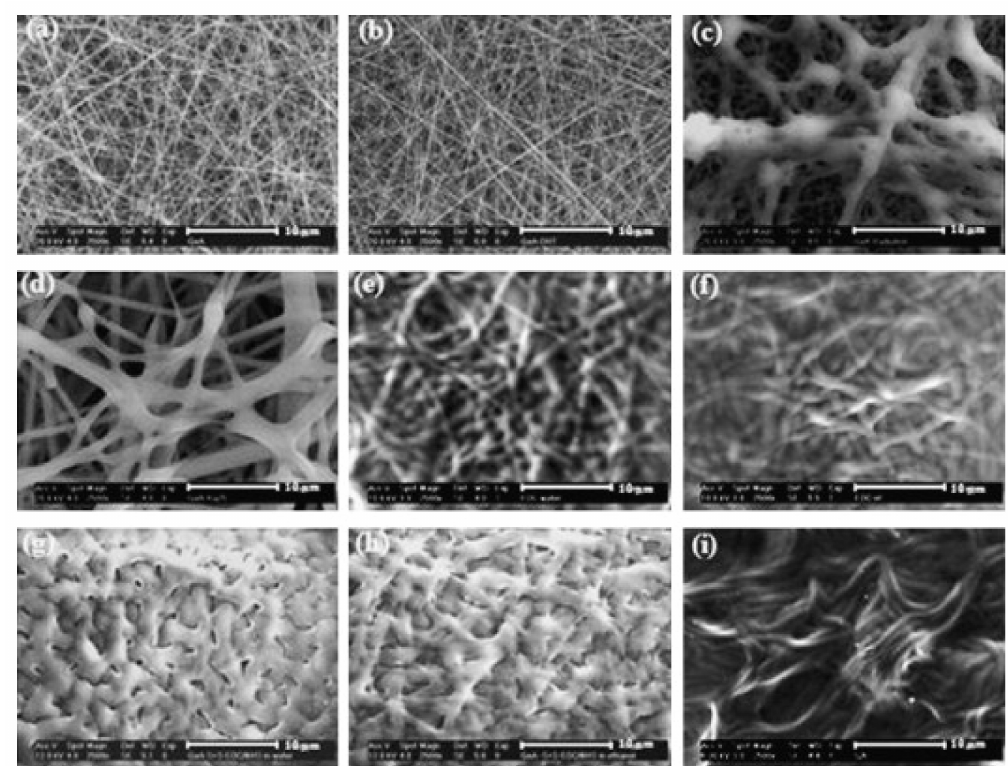
Figure 4. Scanning electron microscopy (SEM) images of electrospun gelatin type A nanofiber mats, crosslinked with differ- ent techniques ( a ) non-crosslinked, ( b ) DHT, ( c ) plasma, ( d ) DHT/plasma, ( e ) DHT/EDCw, ( f ) DHT/EDCe, ( g ) DHT/sEDCw, ( h ) DHT/sEDCe, and ( i ) DHT/vGA (scale bars = 10 µ m). Reprinted from [35]. Copyright 2021